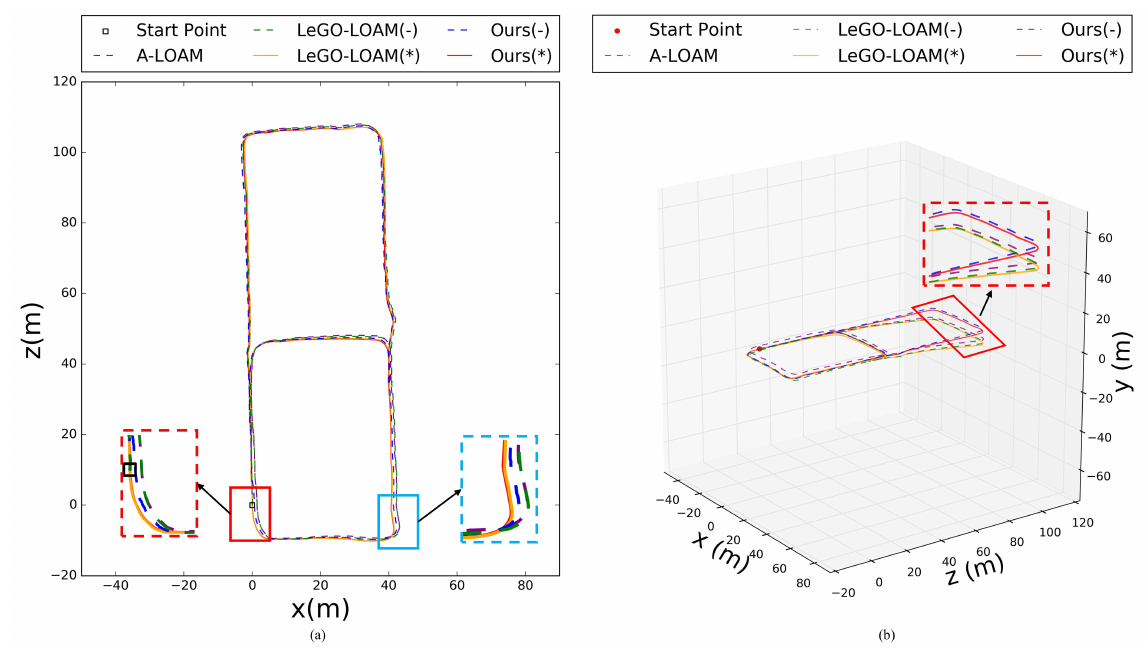
Figure 18. The trajectories of proposed method and state of art LiDAR based methods, including A-LOAM and LeGO- LOAM, where ( a ) is the 2d trajectories in x-z plane and ( b ) is the corresponing 3-D trajectories.